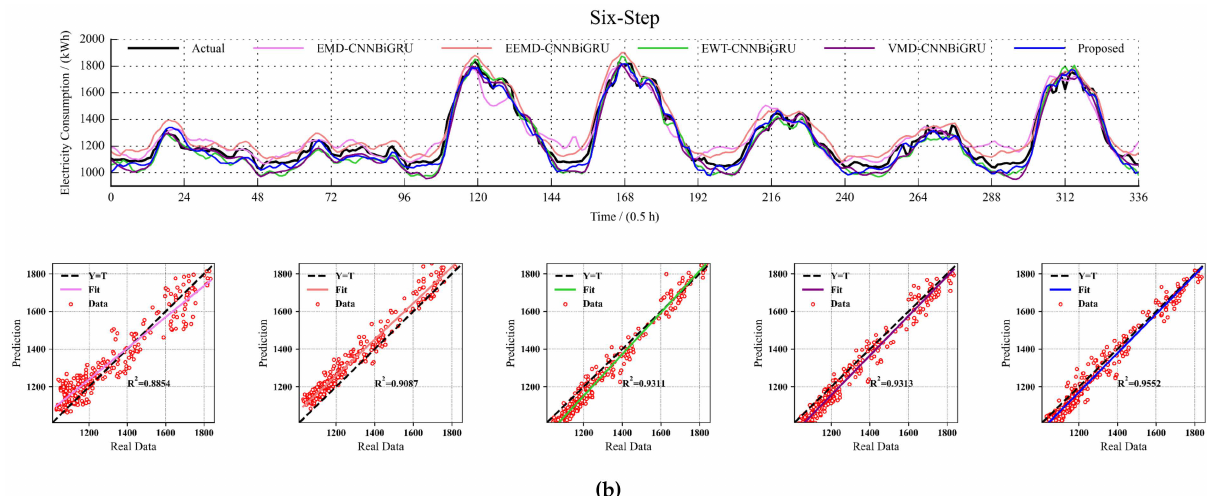
Figure 10. Multi-step ahead building power consumption prediction results from different decompo- sition algorithms: ( a ) one-step and ( b ) six-step.